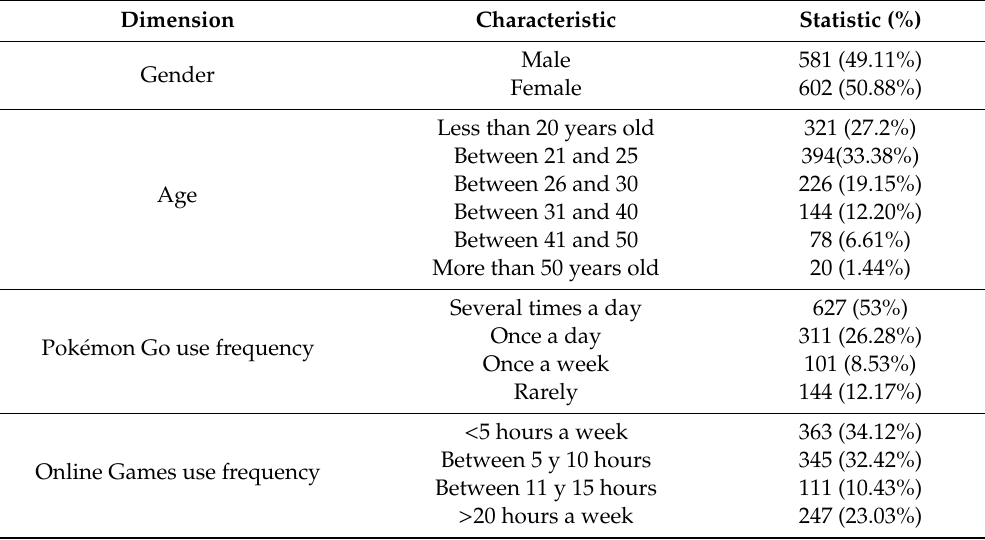
Table 1. Demographic